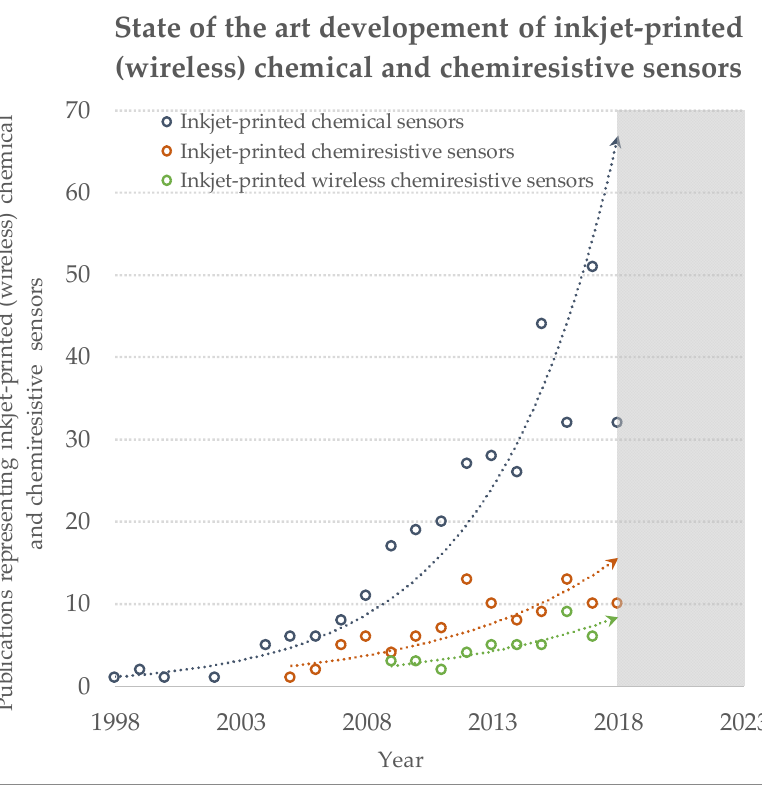
Figure 1. State of the art Development of inkjet-printed (wireless) chemical sensors (Scopus, 22 November 2018).